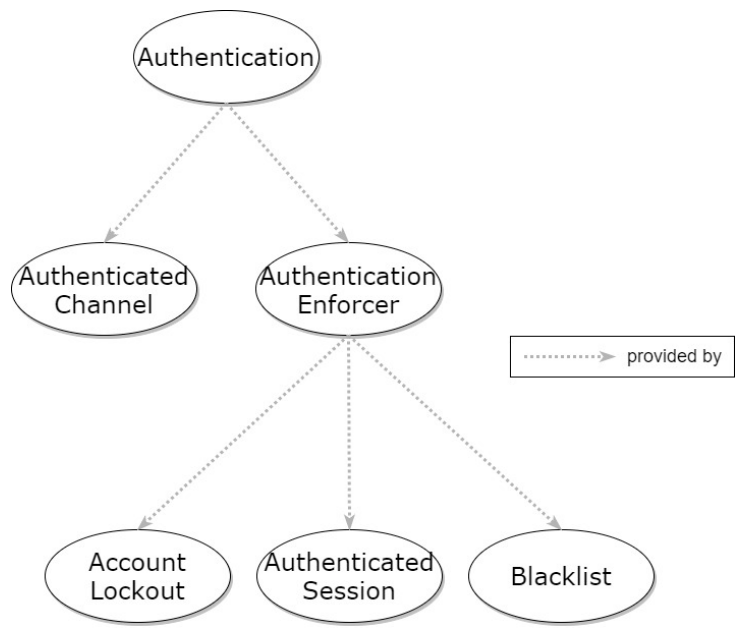
Figure 15. Hierarchical graph of Authentication property and relevant patterns.